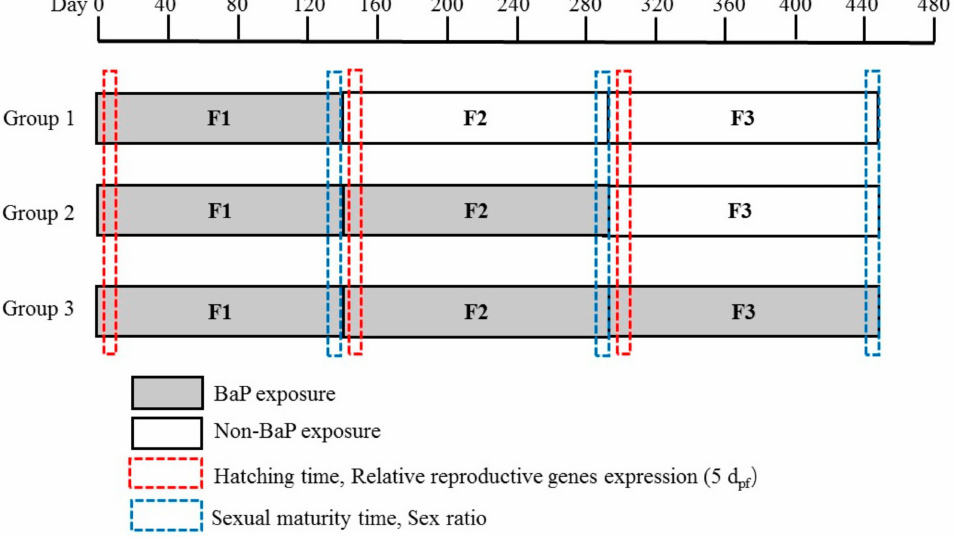
Figure 1. Schematic representation of experiment